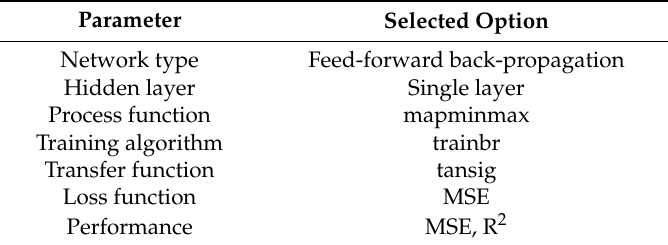
Table 6. Details of the artificial neural network (ANN) parameters developed on the MATLAB